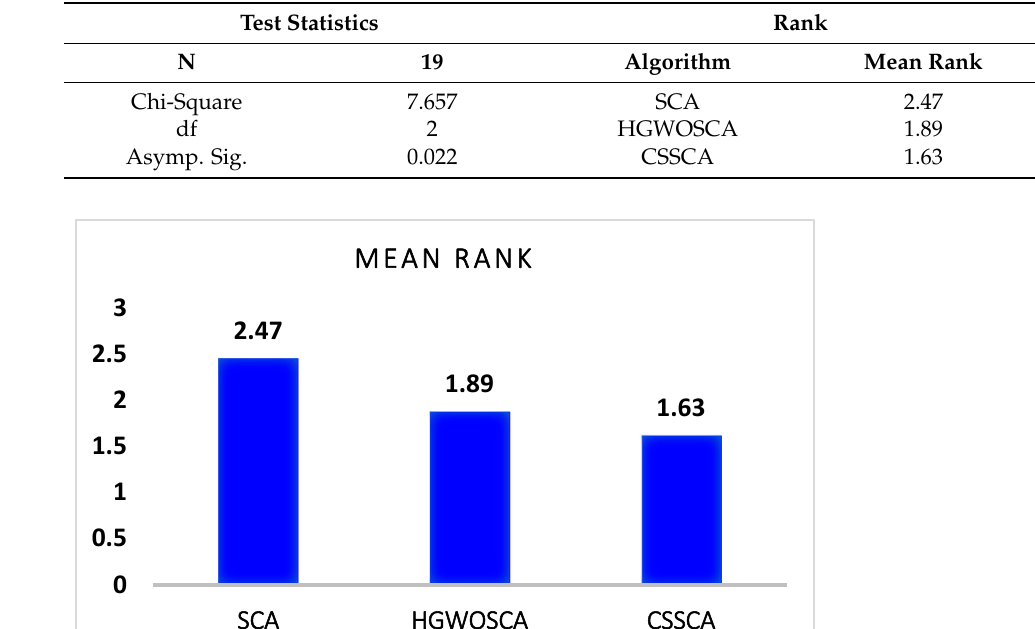
Table 3. The 19 test functions’ Wilcoxon signed-ranks test outcomes. Test Statistics a